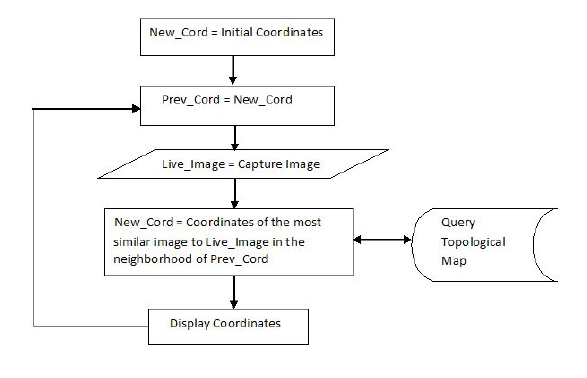
Figure 9: Coordinate axis with robot orientations. All θ values around a single coordinate are displayed. θ is the rotation around the Z-axis. The Z-axis is normal to X-Y plane.